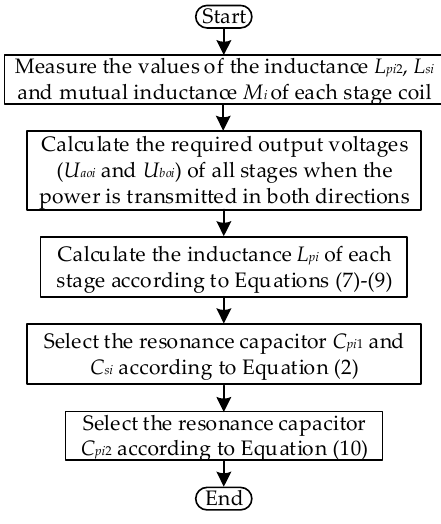
Figure 11. The flowchart of the topology parameter design.